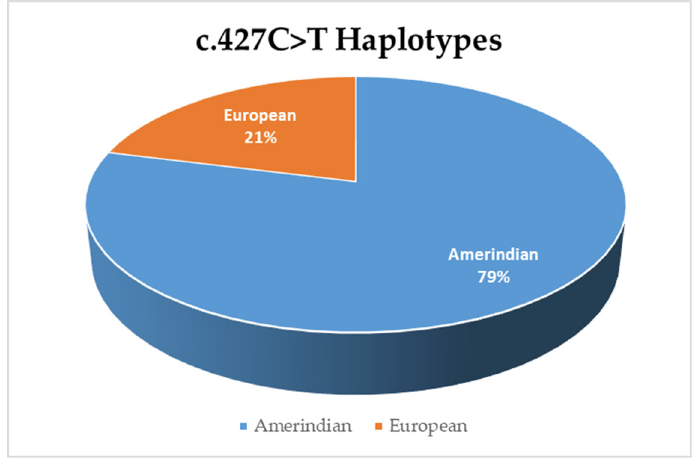
Figure 2. Frequency of the haplotypes in cases positive for the c.427C>T variant.